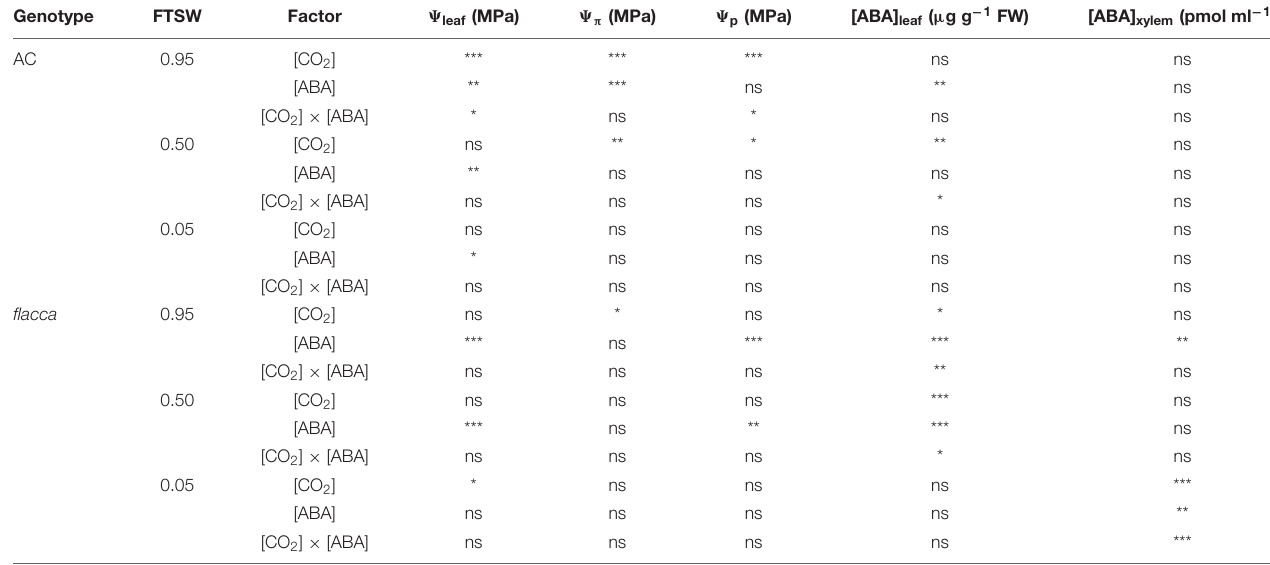
TABLE 3 | Results of two-way ANOVA test showing the statistical significance of the effects of [CO 2 ] and without or with exogenous ABA application ([ABA]) on leaf water potential ( (cid:57) leaf ), osmotic potential ( (cid:57) π ), turgor pressure ( (cid:57) p ), leaf and xylem sap ABA concentrations ([ABA] leaf , [ABA] xylem ) in AC and flacca during progressive soil drying.